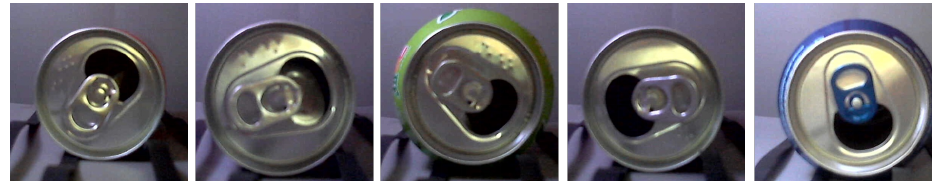
Figure 10. Front view of five different aluminum